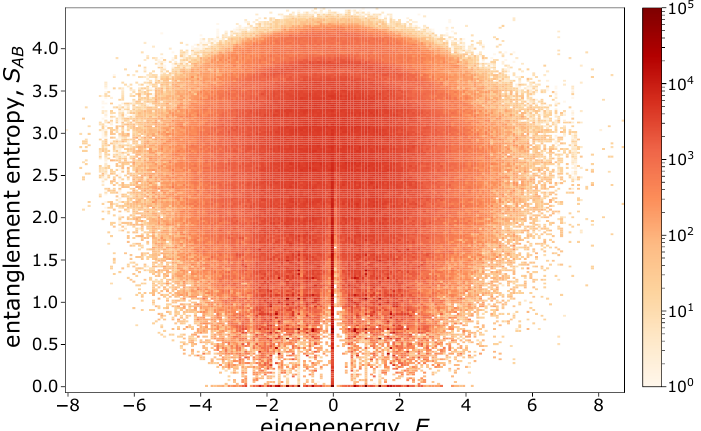
Figure 14: Bipartite entanglement entropy of eigenstates as a function of their eigenenergy, for the entire spectrum of the model ˆ H on the 5 × 5 lattice. The color denotes the number of states with a particular S